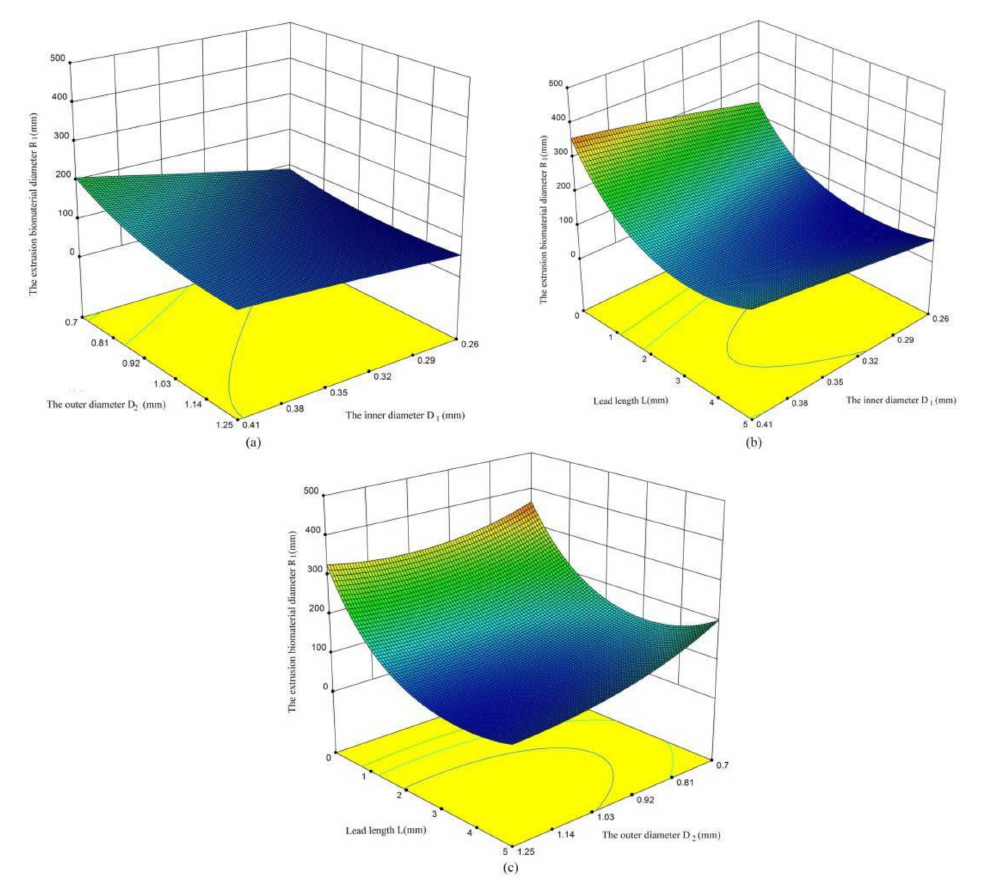
Figure 8. The influence of various factors on the extrusion biomaterial diameter. ( a ) the influence between outer diameter and lead length on R 1 ; ( b ) the influence between lead length on and inner diameter on R 1 ; ( c ) the influence between inner diameter and outer diameter on R 1